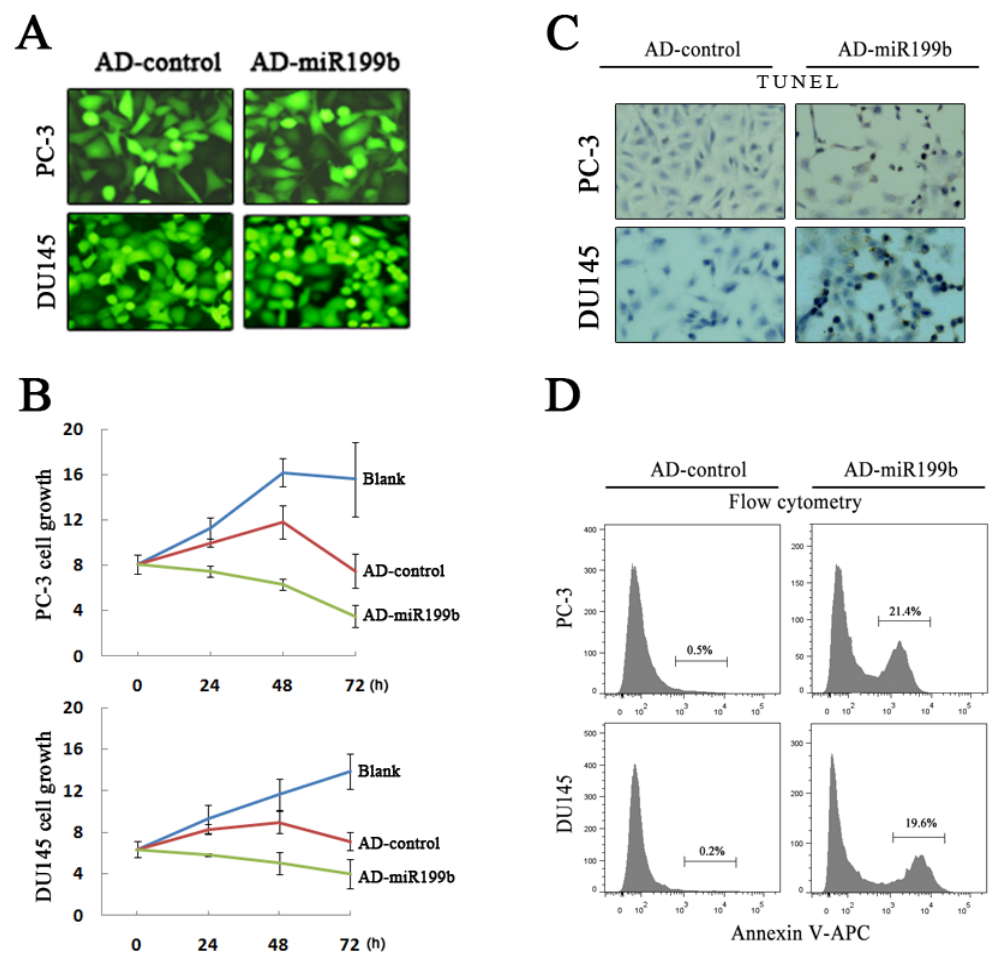
Figure 4. Cell behavior by artificial overexpression of miR199b in PC-3 and DU145 cells under normoxic condition. ( A ) the efficiency of Ad-miR199b and Ad-control infection was shown by homogenous green fluorescence protein expression of the infected cells; ( B ) cell growth was significantly inhibited concomitant with the miR199b- HIF-1 α expression change; ( C , D ), increased cell death upon the miR199b- HIF-1 α expression change as shown by flow cytometry analysis of percentage of Annexin V-APC–stained apoptotic cells ( D ) and TUNEL assays ( C